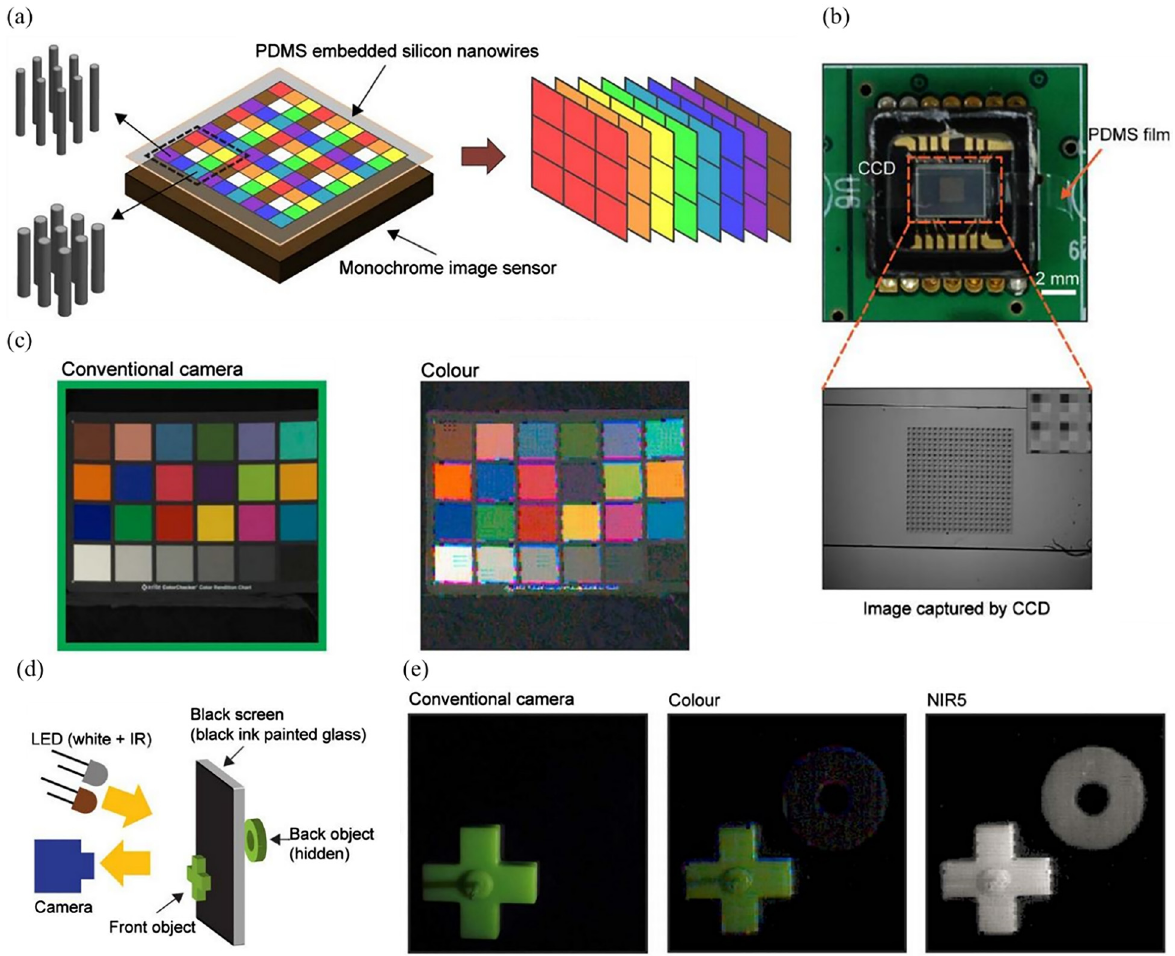
Figure 9: Si nanowire-based spectral filter integrated with CCD image sensor for multispectral imaging in visible and infrared (IR) wavelength